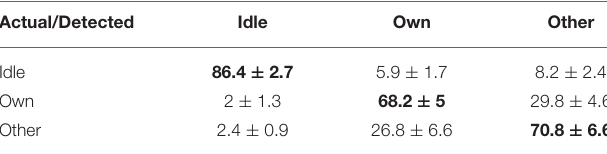
TABLE 3 | Averaged state detection accuracies across subjects